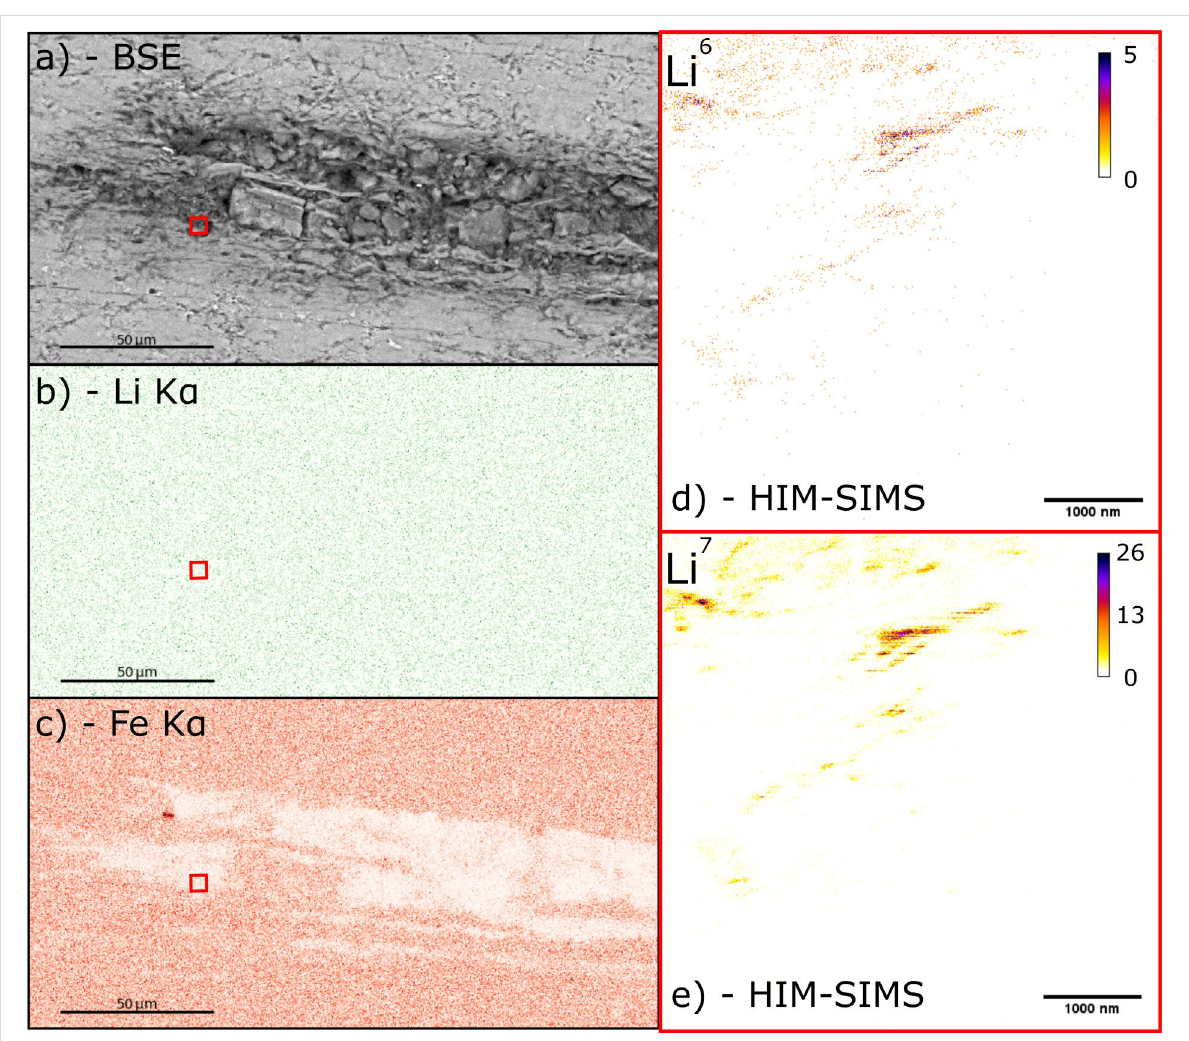
Figure 7: a) Backscatter electron image of the region of interest. The red square shows the region mapped using HIM–SIMS; b) Li EDS map of the region shown in a); c) Fe EDS map of the region shown in a); d) 6 Li map of the region within the red square in a) using HIM–SIMS; e) 7 Li map of the region within the red square in a) using